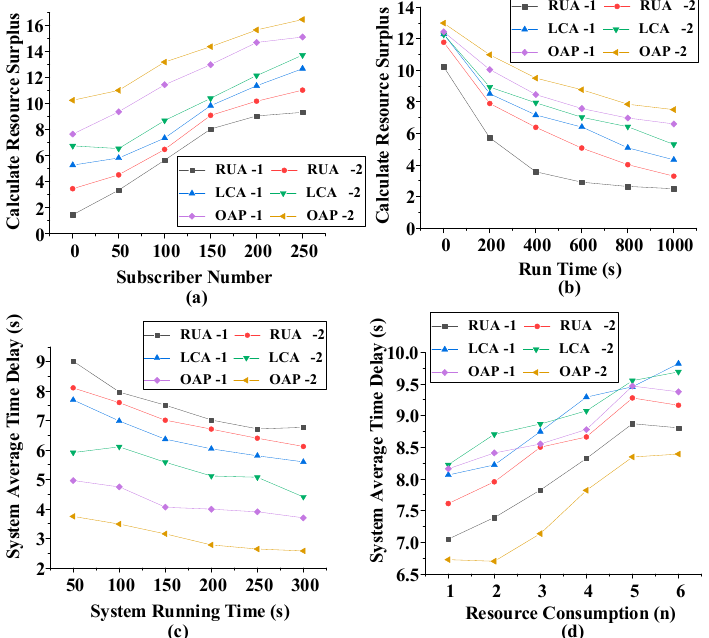
Figure 10. Parameter changing curves of the resource remaining and the average system delay: ( a ) the relationship between the user number and resource remaining; ( b ) the relationship between the system running time and resource remaining; ( c ) variation curves of average system delay with the increase in system running time; ( d ) variation curves of average system delay with resource consumption rate.